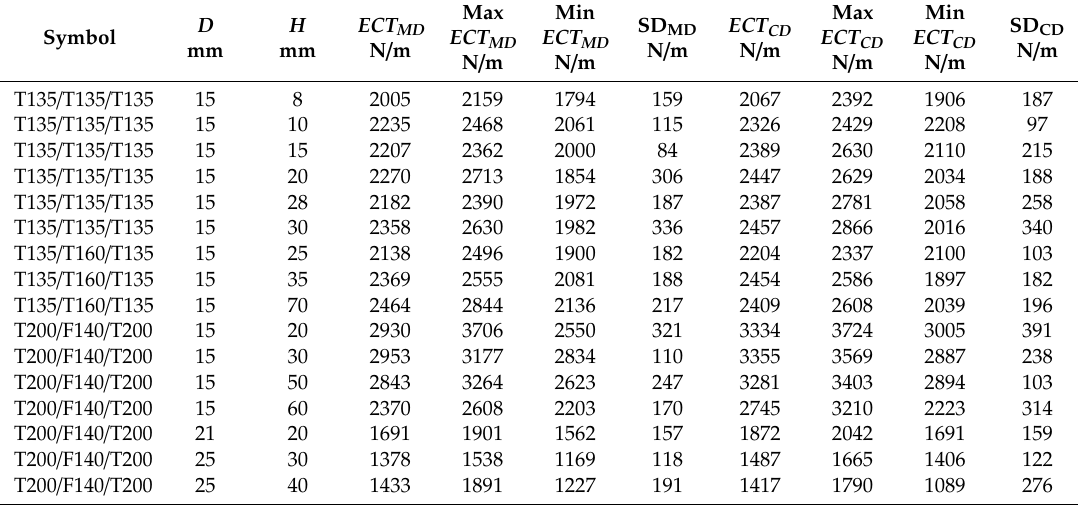
Table 2. ECT measurement results: means of ten measurements and standard